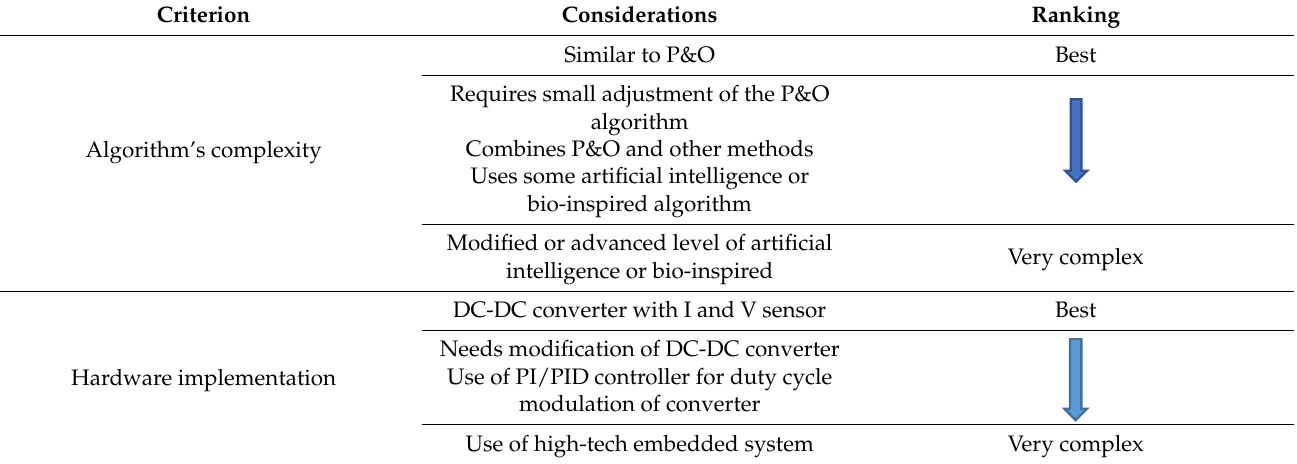
Table 7. Criteria for determining MPPT rankings redrawn with data from [43].